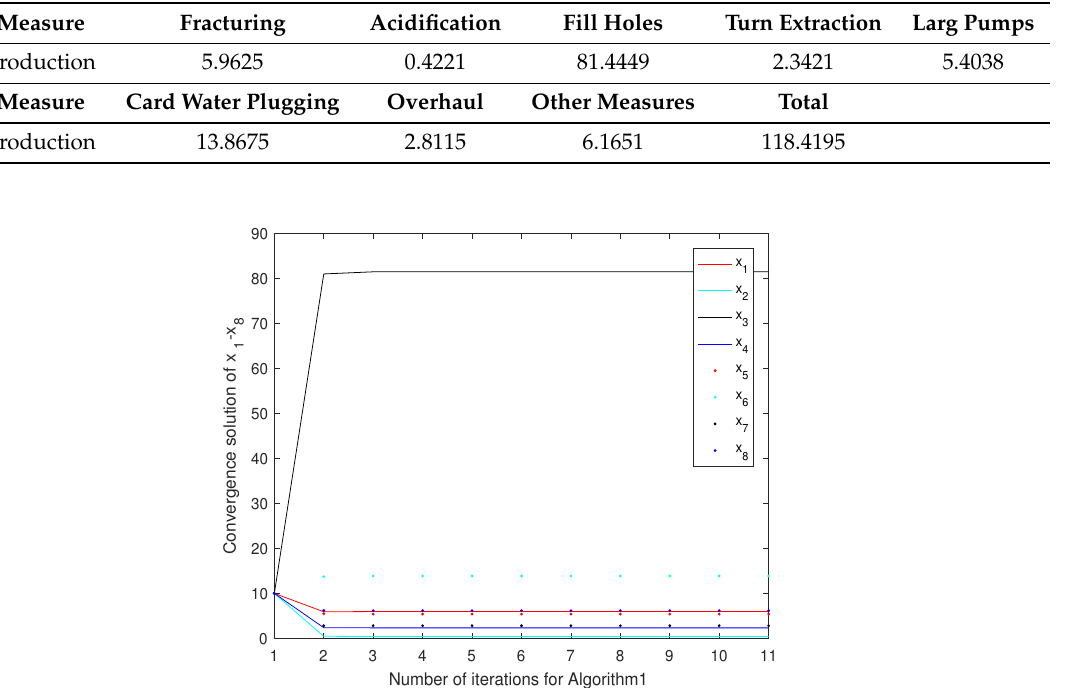
Table 5. Result of measure production and total production (10 4 t).